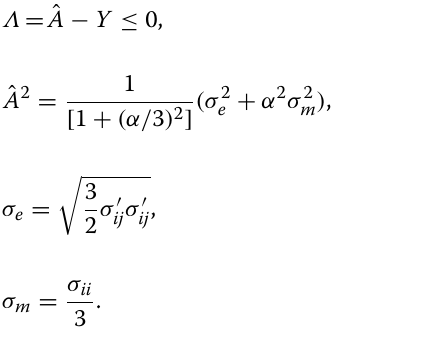
Figure 7 Experimental and simulation settings: a Compression of battery under flat plates, b Flat plate test, c Rigid rod test, d Hemispherical punch test, e Stress-strain constitutive properties under